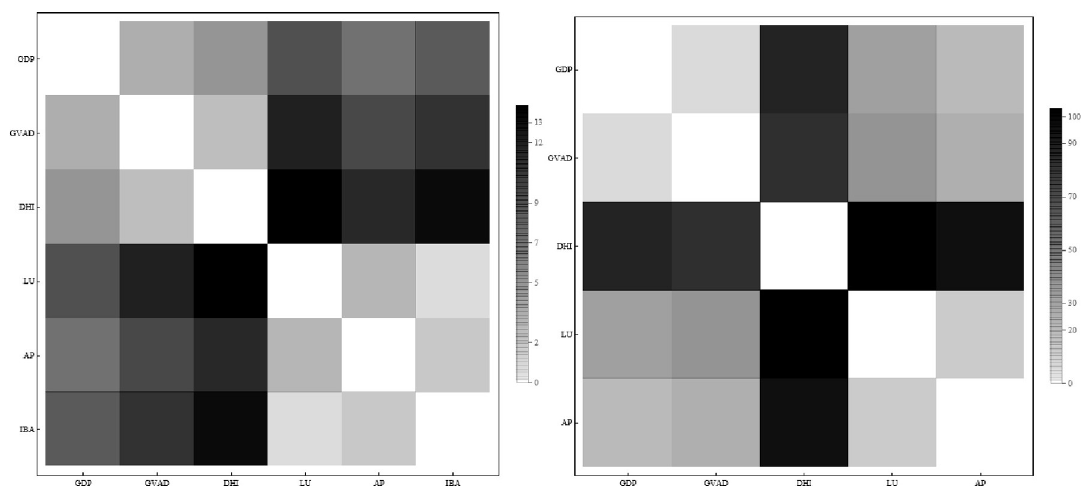
Fig 5. Wasserstein-1 distance matrix of dominant layers for Central and Eastern Europe regions (left hand side) and Western Europe regions (right hand